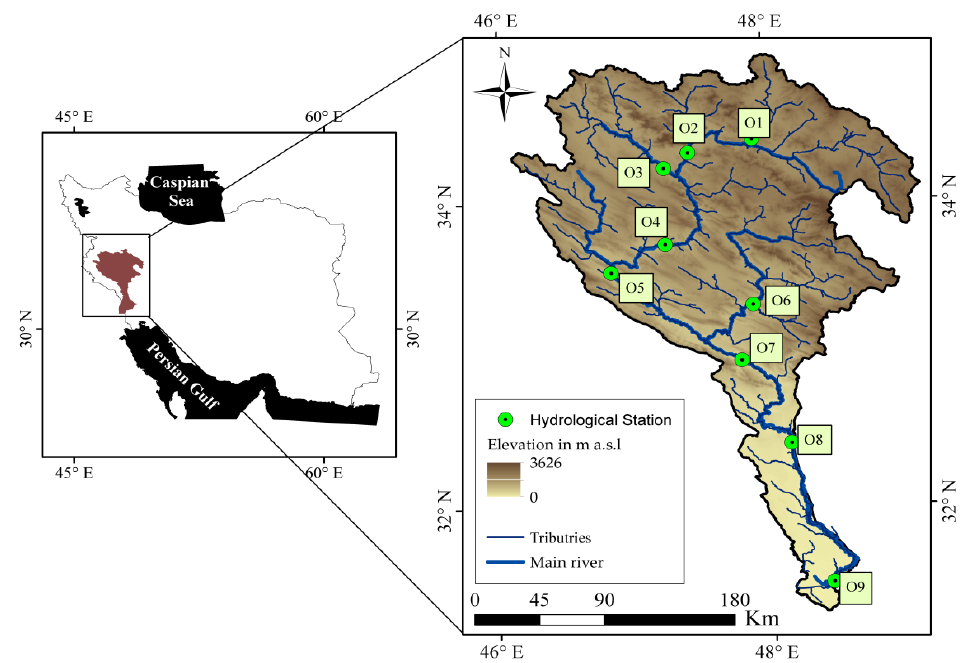
Figure 1. Left : the Karkheh River Basin and its location on a map of Iran. Right : the figure shows elevation, main river, and nine outlets (O1–O9) used in calibration.